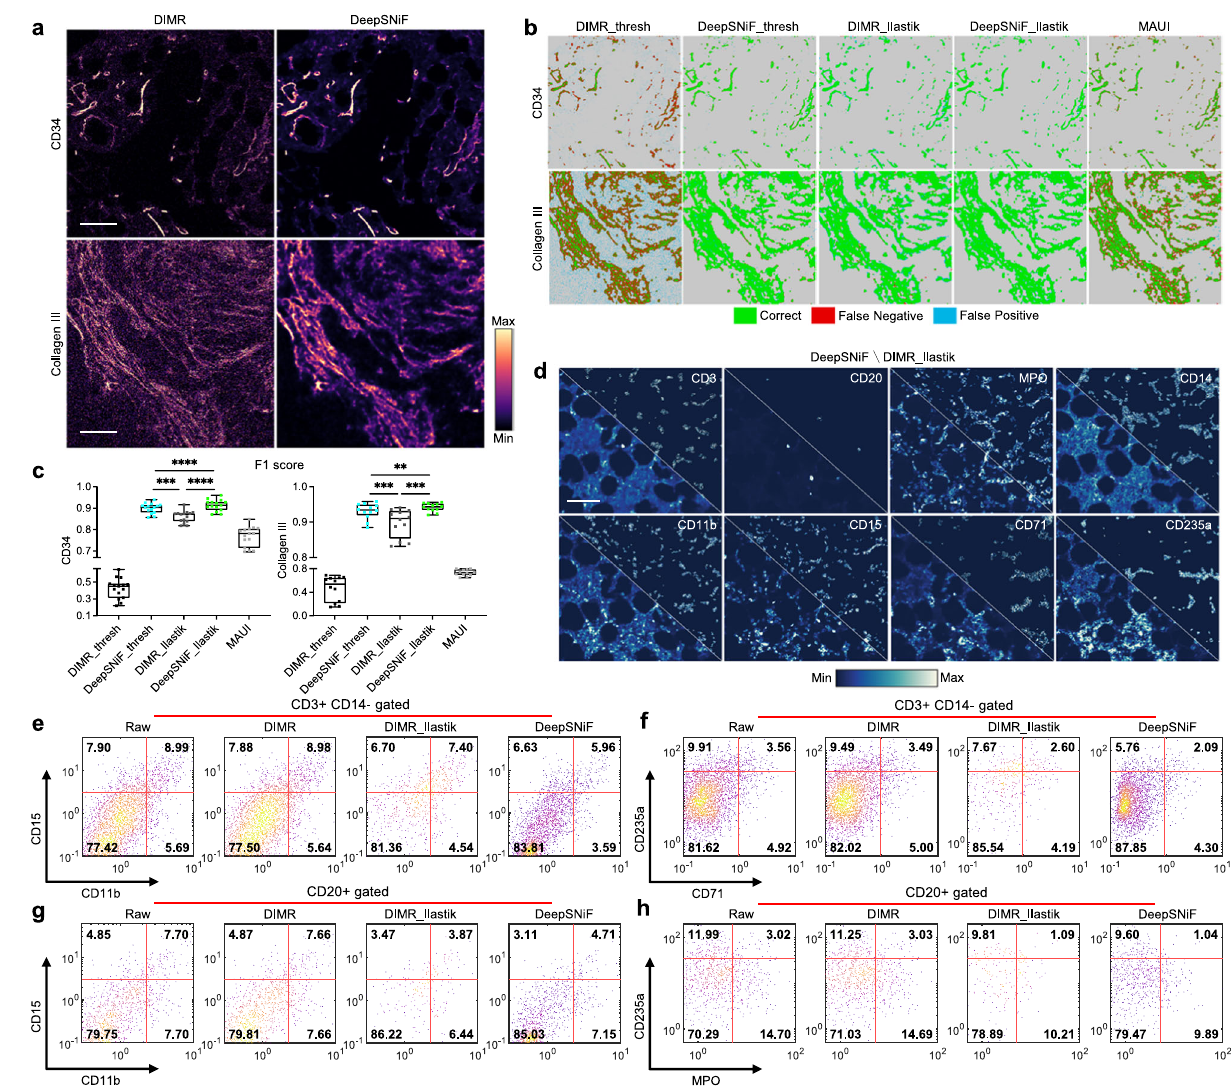
Fig. 2 | IMC-Denoise enables background noise removal and enhances down- stream analysis of the human bone marrow IMC dataset. a Examples of DIMR and DeepSNiF-processed IMC images labeled with CD34 and Collagen III. b Visual inspection of background removal results of DIMR and DeepSNiF-processed ima- ges, in which DIMR_thresh and DeepSNiF_thresh are binarized with the optimal thresholds (Supplementary Figs. 25 and 26), DIMR_Ilastik and DeepSNiF_Ilastik are segmented by the Ilastik software package, and MAUI results are the DIMR images processed by the MAUI software package (Supplementary Fig. 27), respectively. Manualannotatedimagesareservedasgroundtruths. c AfterDeepSNiFdenoising, the background removal accuracy improves signi fi cantly in terms of F1 score, for both CD34 and Collagen III-labeled images ( n =15 independent images for CD34 and n =12independentimagesforCollagenIII).Notably,DeepSNiF_Ilastikachieves